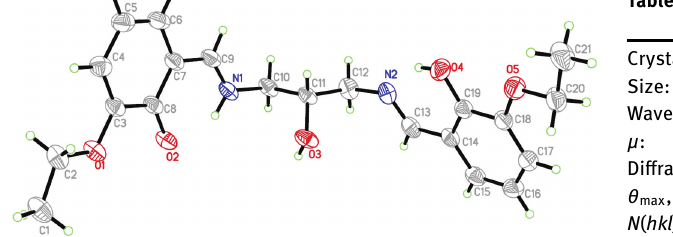
Table 1: Data collection and handling.